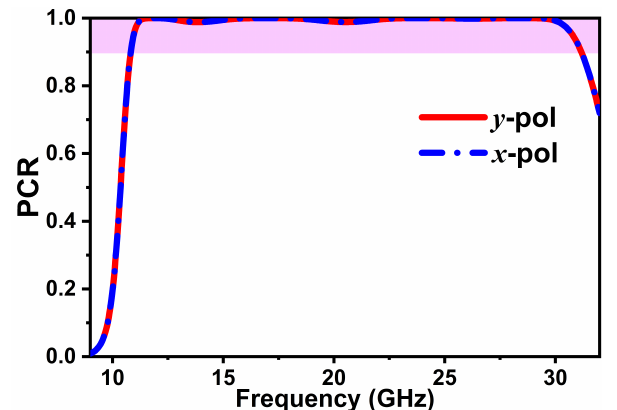
Figure 5. Polarization conversion ratio under normal x - and y -polarized